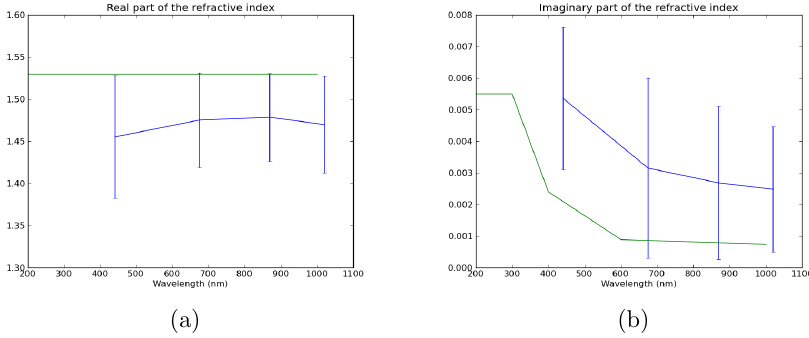
Figure 8. (a) Real part of the refractive index inverted from the AERONET measurements averaged for 22–24 June and 2–4 July (blue line: average and extreme of the 29 available hourly AERONET values) and value used by CHIMERE (green line). The blue error bars indicate the extreme values measured by AERONET during these 6 days. (b) Same as (a) but for the imaginary part of the refractive index.